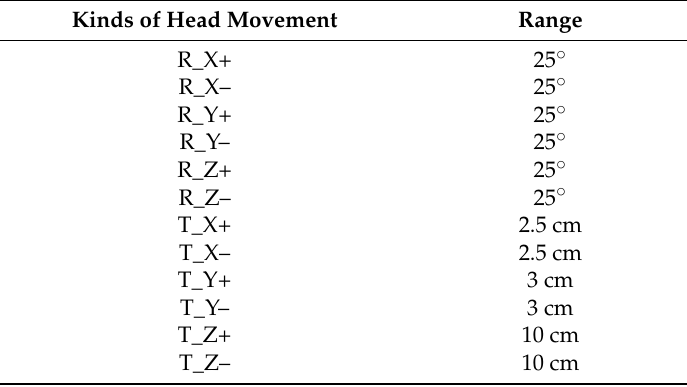
Table 5. Range of head movements allowed in our